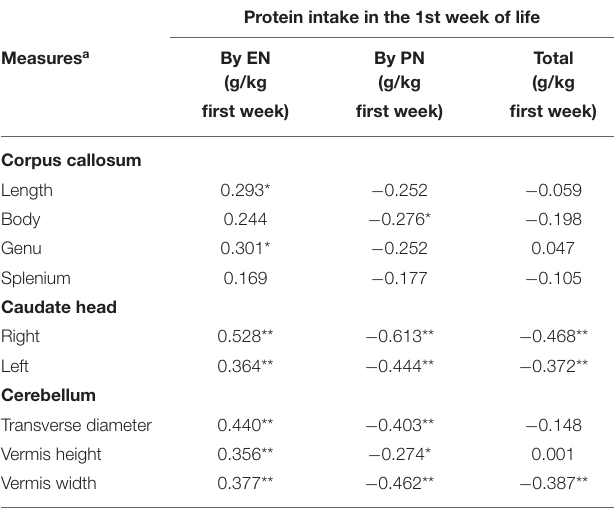
TABLE 2 | Correlations between cerebral structures linear measures and protein intake. Protein intake in the 1st week of life